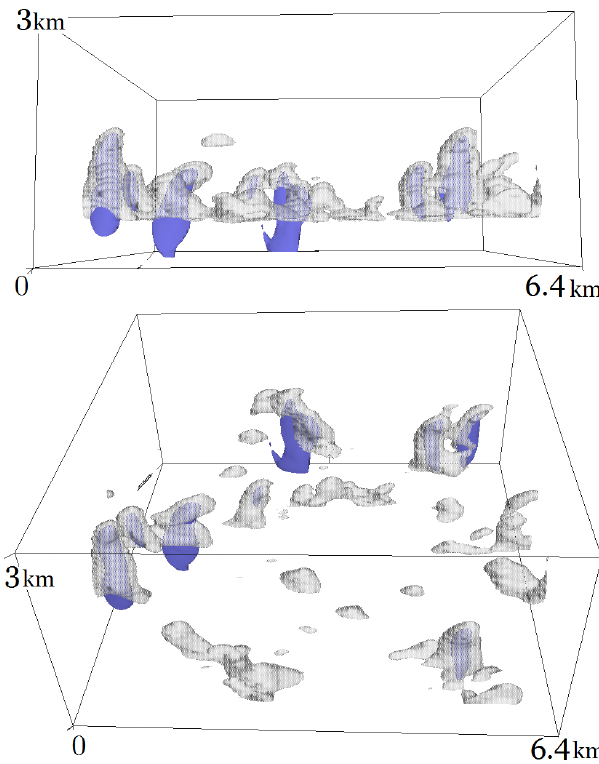
Fig. 4. Snapshots of cloud water mixing ratio q c (transparent grey) and rain water mixing ratio q r (solid blue) at the 6th hour of the simulation. The isosurfaces show values q c = 0 . 05gkg − 1 and q r = 0 . 02gkg − 1